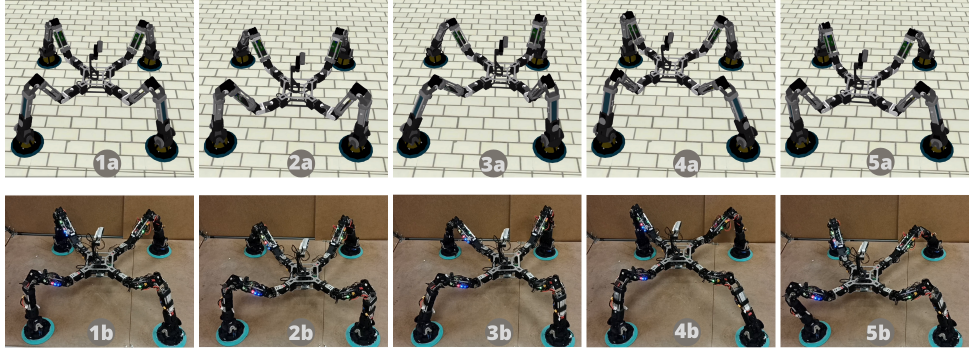
Figure 7. Results for the digital twin ( up ) and physical ( down ) organisms while carrying out a circular trajectory. Pictures 1 show the initial configuration, and the rest show catches of the